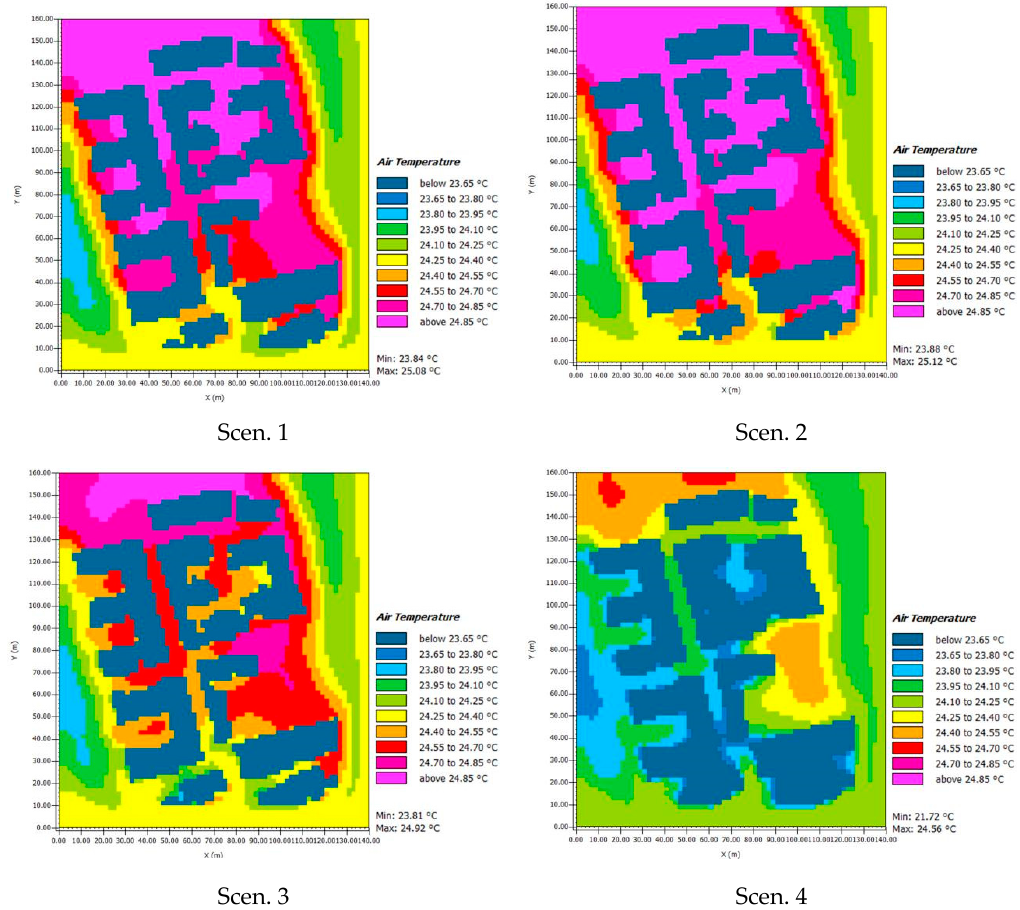
Figure 7. Outdoor air temperature of the four scenarios at 8 a.m.